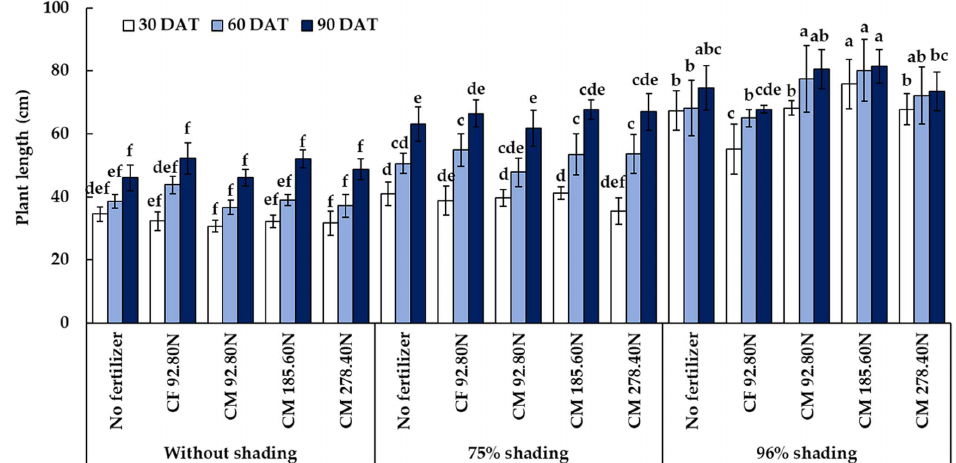
Figure 1. Plant length of vegetable fern grown under different shading and fertilizer application treatments at each DAT (days after transplanting). Values are means with standard deviations ( n = 4). The different letters above the bars indicate statistically significant differences by Duncan’s multiple range tests ( p < 0.05) within each harvesting month. Comparing the different levels of shading, it was noted that shading levels were positively correlated with plant width ( p ≤ 0.05). At 30, 60, and 90 days after transplanting, vegetable ferns under 96% shading developed the most expansive width, followed by the 75% shaded vegetable ferns, while the non-shaded vegetable fern had the narrowest average plant widths. However, when fertilizer application factors were observed, it was discovered that cow manure applied at a rate of 185.60 kg N ha −1 resulted in the greatest plant width throughout development (Table 3). In addition, at 60 and 90 days after transplanting, shading and fertilizer significantly affected the width of the vegetable fern ( p ≤ 0.05). The 96% shading treatment, paired with cow manure application at a rate of 185.60 kg N ha −1 , resulted in the greatest plant width at 60 and 90 days after transplanting. On the other hand, the absence of shading, in combination with all fertilization treatments,